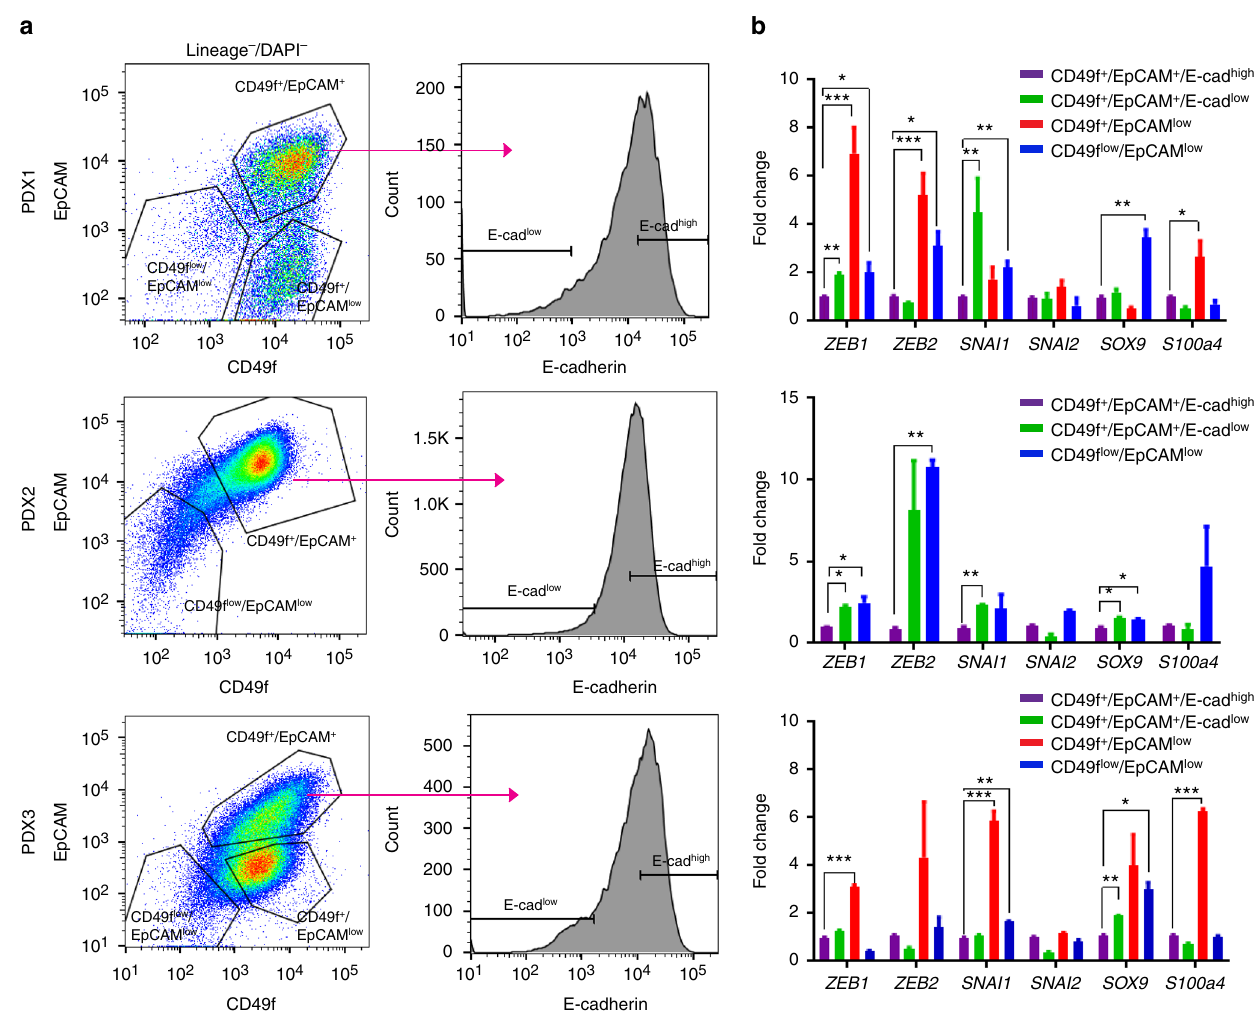
Fig. 4 Tumorigenic capacity of breast epithelial cells is independent of EMT gene expression. a H2kd − CD45 − DAPI − cells from PDX1 (upper), PDX2 (middle), and PDX3 (bottom) stained with CD49f and EpCAM. Sorting gates are depicted in the FACS plot (left panels). The CD49f + /EpCAM + population is further divided based on E-cadherin expression (right panels). All populations were double sorted and used in transplantation assays. See Supplementary Fig. 3 for sorting scheme and Table 1. b Quantitative gene expression analysis in PDX1 (upper), PDX 2 (middle), and PDX3 (bottom) for CD49f + /EpCAM + /E-cadherin high , CD49f + /EpCAM + /E-cadherin low , CD49f + /EpCAM low and CD49f low /EpCAM low . The data are shown as the mean ± SEM, ( n = 3 biological replicates in PDX1 and PDX2 and n = 2 biological replicates in PDX3). * p < 0.05, ** p < 0.01, *** p < 0.001 ( t